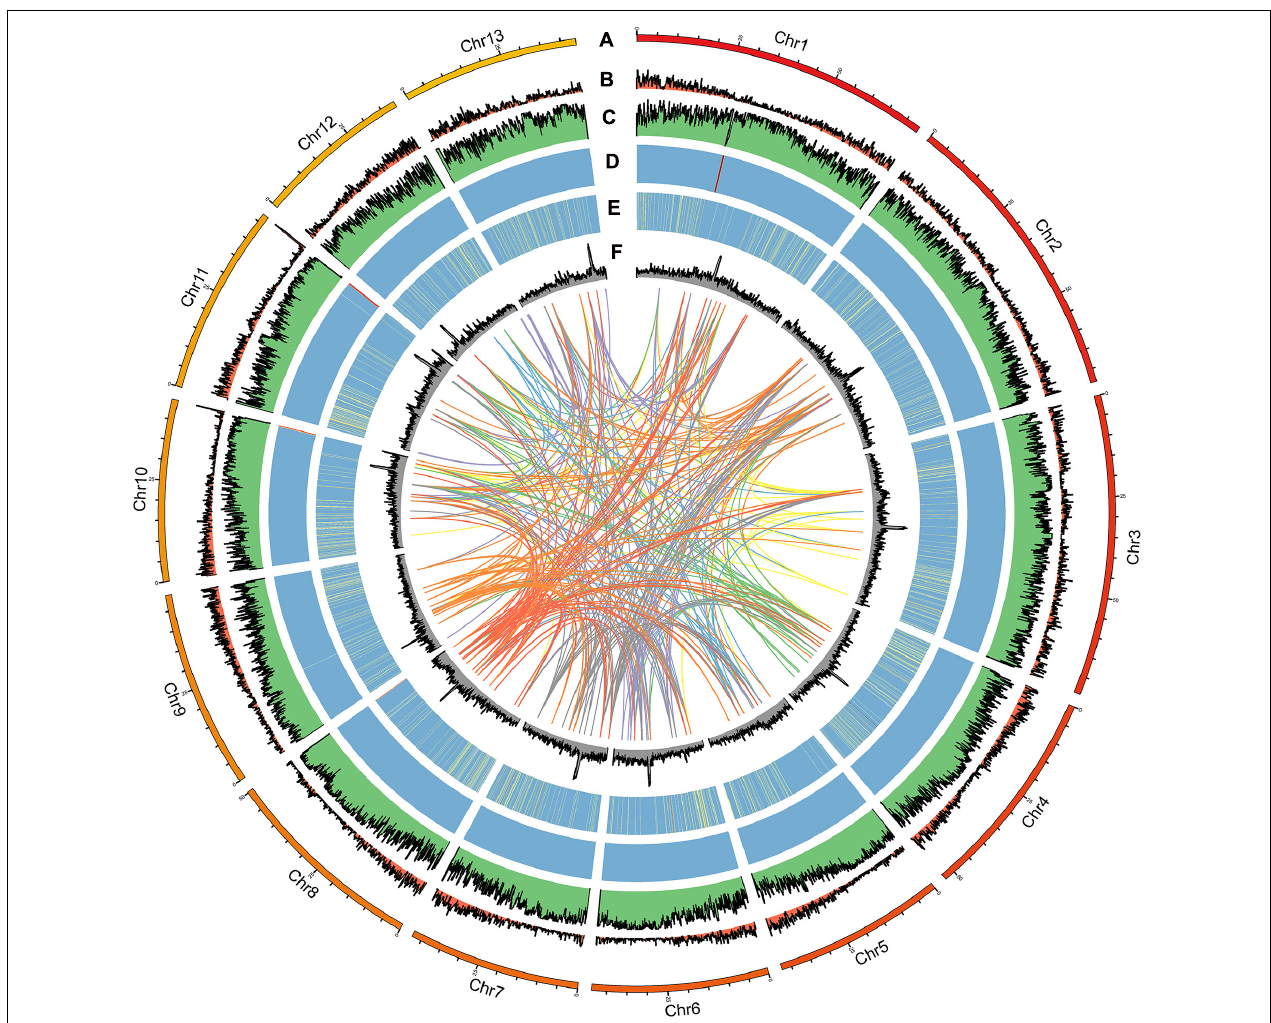
FIGURE 2 | Distribution of A. pseudosieboldianum genomic features. (A) Circular representation of the chromosome, (B) gene density, (C) repeat density, (D) rRNA, (E) tRNA, and (F) GC